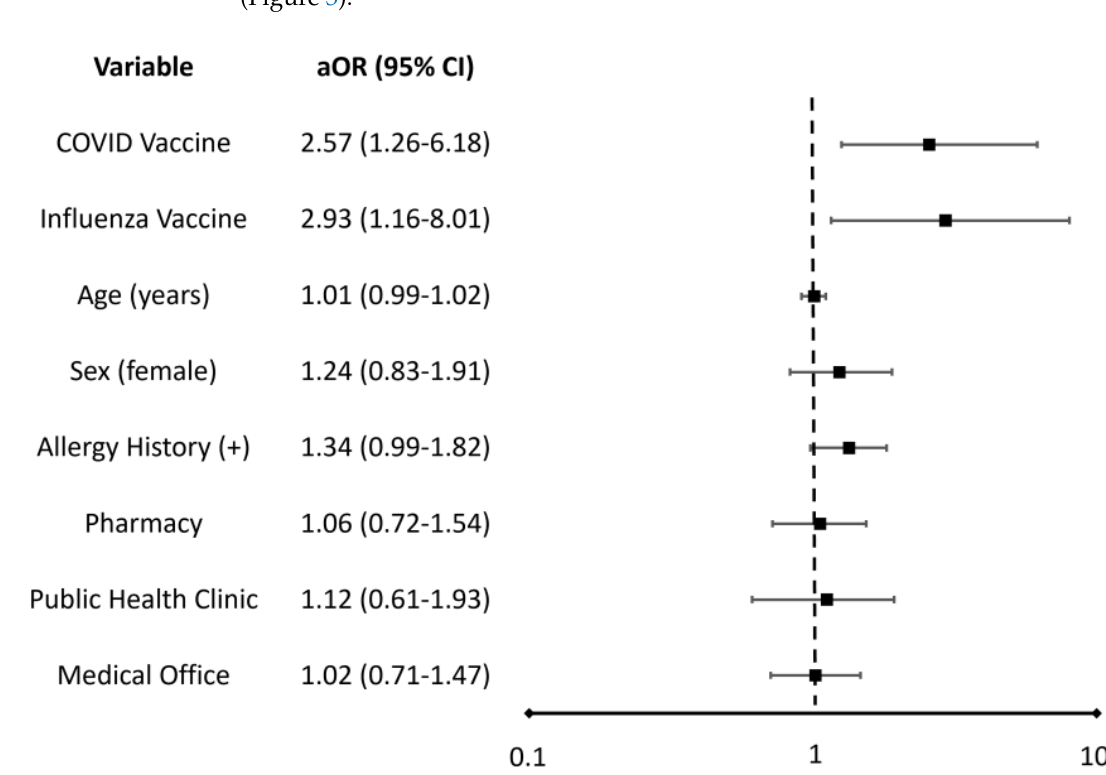
Figure 3. Adjusted odds ratios (aOR) and 95% confidence intervals (CI) of hospitalization associated with reports of post-vaccination anaphylaxis for each regression variable *. When holding other covariates constant in the regression analysis, an odds ratio greater than 1 indicates that the outcome of hospitalization is more likely to occur when the variable is present. Conversely, an odds ratio less than 1 indicates that the outcome is less likely to occur when the variable is